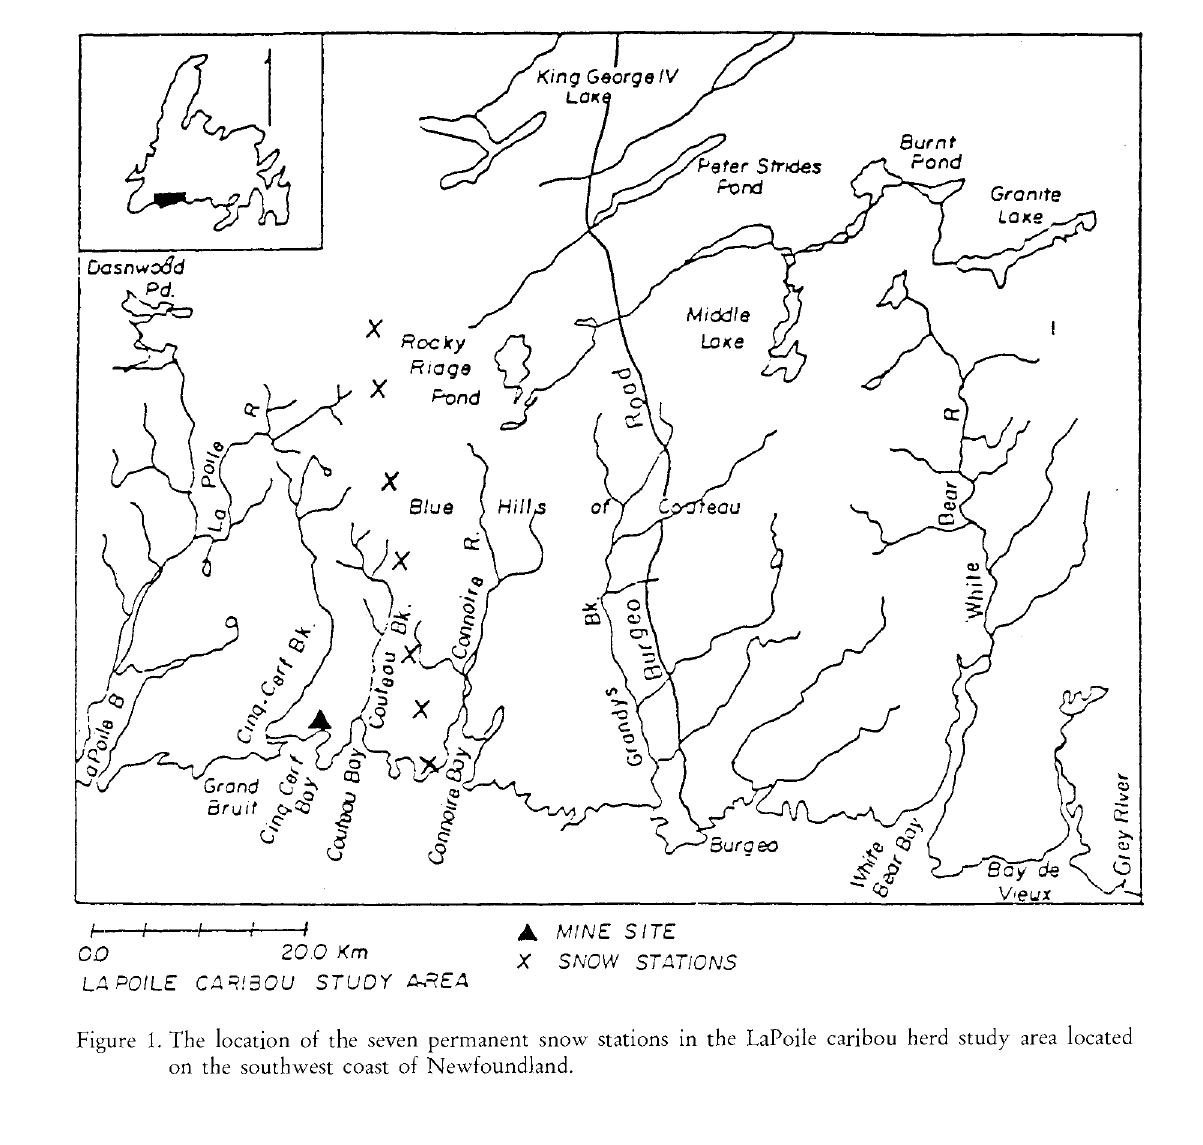
Figure 1. The location of the seven permanent snow stations in the LaPoile caribou herd study area located on the southwest coast of